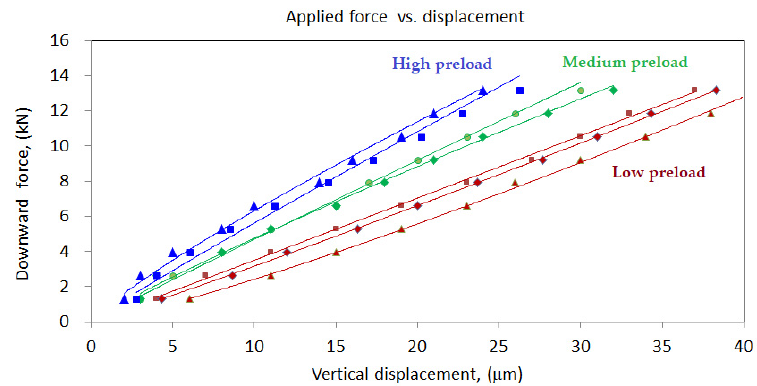
Figure 3. Load–deflection curves of the sliding blocks in radial direction. Table 2. Preload and rigidity of the linear guides.